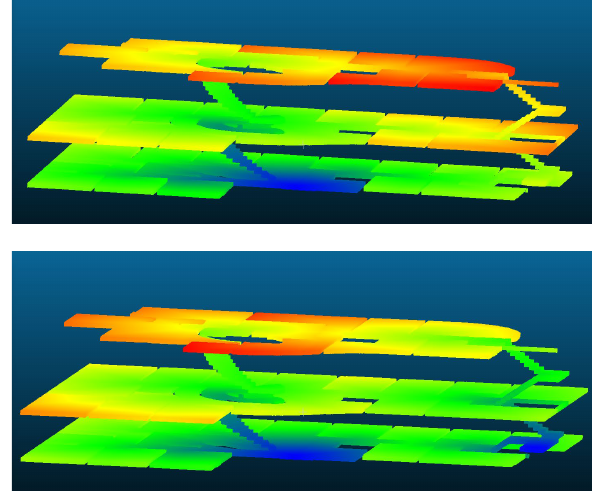
Fig. 10: Distance fields from anywhere in the navigable space to a single building exit (top) or multiple (bottom) exits (in